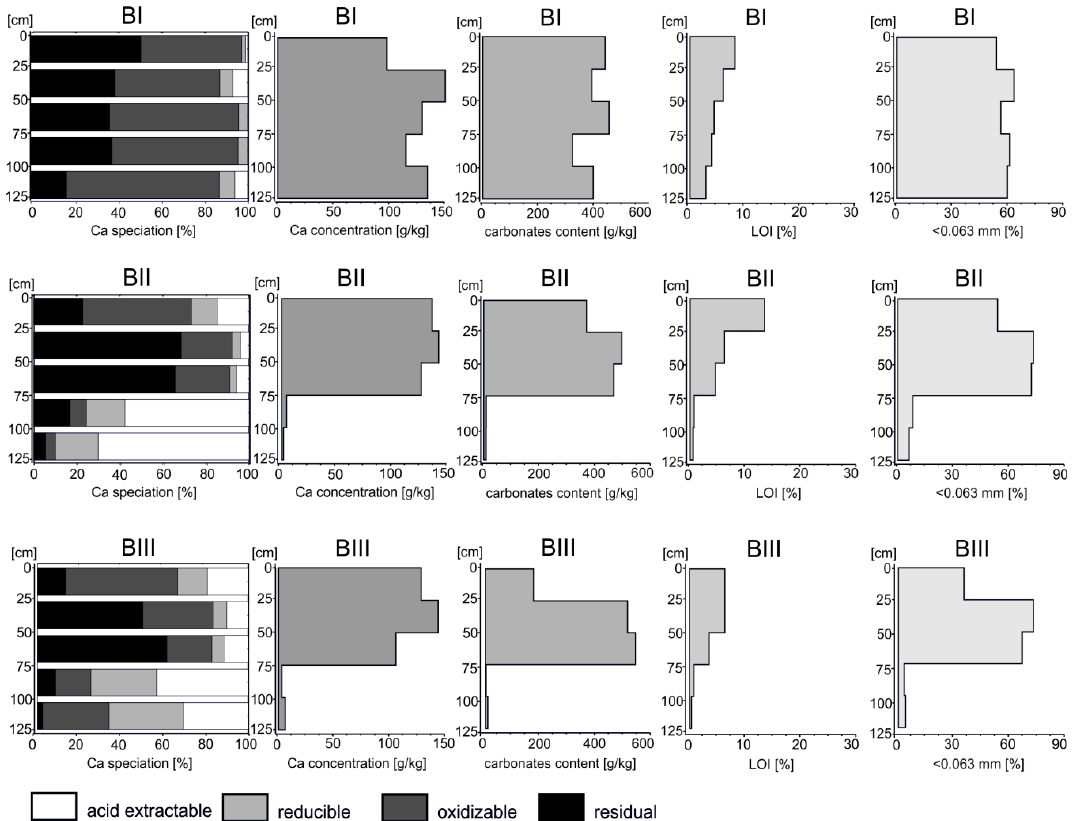
Figure 3. Carbonates, LOI, fine sediment and Ca content and speciation in the Bia ł a River sediments.